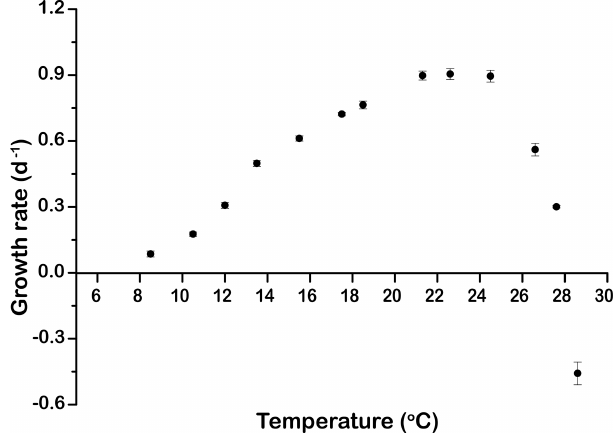
Figure 1. Thermal performance curve showing cell-specific growth rates (d − 1 ) of Emiliania huxleyi CCMP371 across a temperature range from 8.5 to 28.6 ◦ . Symbols represent means, and error bars are the standard deviations of three replicates at each temperature, but in many cases the errors bars are smaller than the